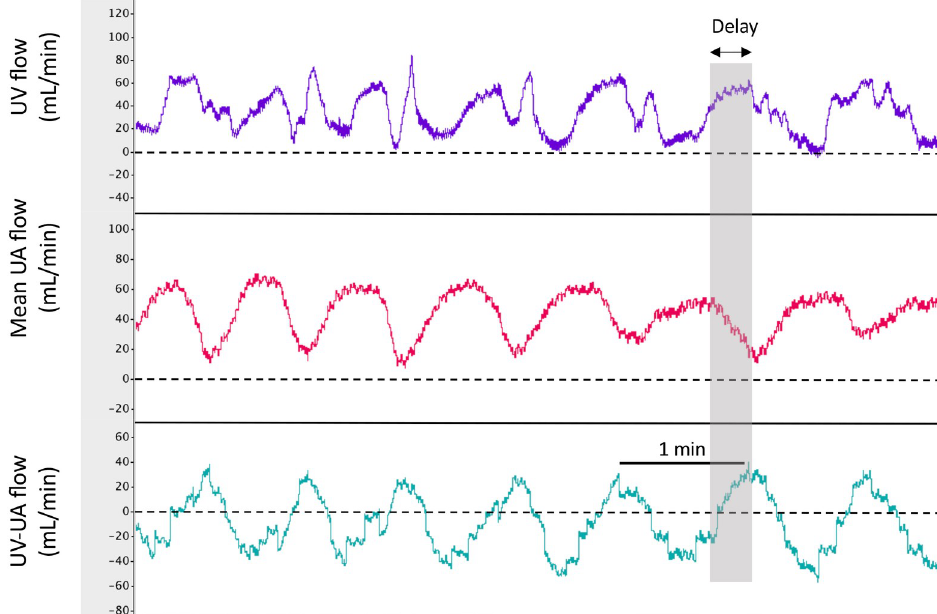
Fig 5. Physiological recordings of mean blood flows in the umbilical vein (UV), umbilical artery (UA) and the arithmetic derivation of UV-UA flow in a newborn lamb during consecutive uterine contractions. A value for UV-UA flow that is below zero indicates a net loss of blood flow from the lamb into the placenta. Note that during the contraction, both UV and UA flow decrease to near zero, but that the reduction in UV flow is significantly delayed compared to the UA flow. As a result, much of the reduction in UV flow occurs while the UA flow is recovering, resulting in a net loss of blood from the lamb. However, with the onset of the next contraction, because the reduction in UV flow is delayed, there is a net flow of blood from the placenta to the lamb.